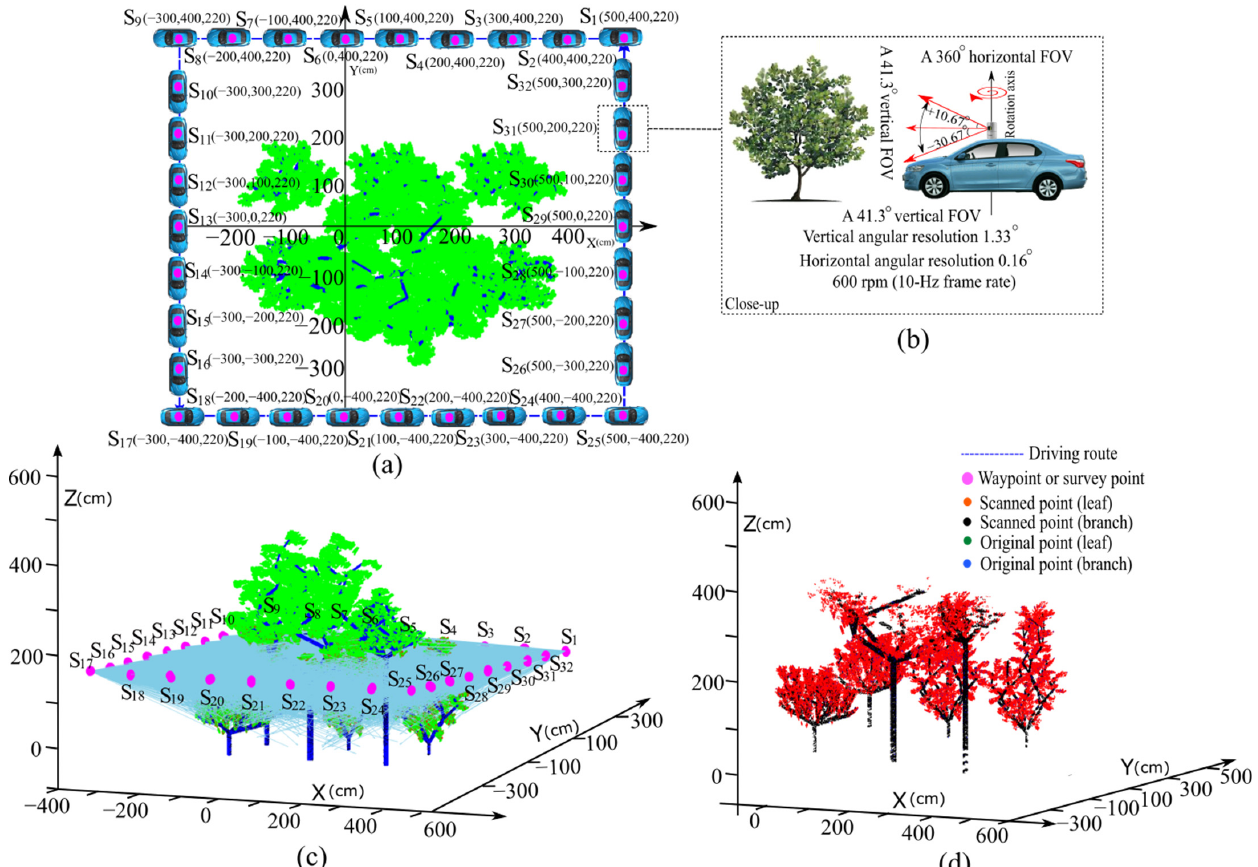
Figure 5. Our program diagram shows the simulation of the ground ‐ based MLS for the modeled forest plot. ( a ) The set ground vehicle’s path around the target trees and the sensor fires lasers to capture the point cloud from different lateral sides. ( b ) A standing Velodyne HDL-32E was installed on the car’s roof to guarantee a +10.67 ◦ to − 30.67 ◦ vertical scanning FOV and 360 ◦ horizontal scanning FOV, with the settable angular resolution and car running speed. ( c ) Equivalent diagram illustrates the simulation of a ground-based MLS system designed to acquire forest-scanned data. ( d ) The collected scanned data from mobile LiDAR with a ground vehicle; occlusion effects are